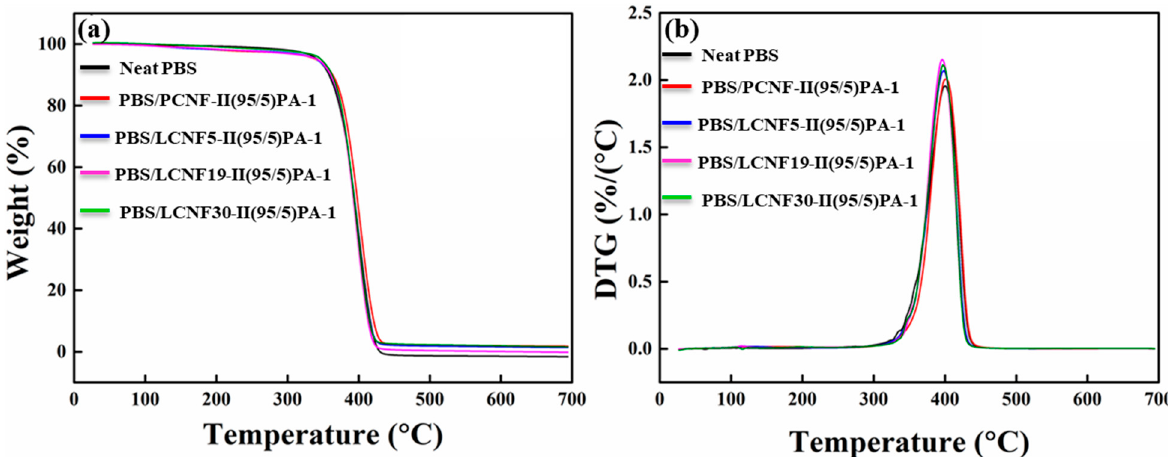
Figure 9. TGA ( a ) and DTG ( b ) graph of neat PBS a, PBS/PCNF (95/5), and PBS/LCNF (95/5) with different lignin contents (Heating rate 10 °C/min).